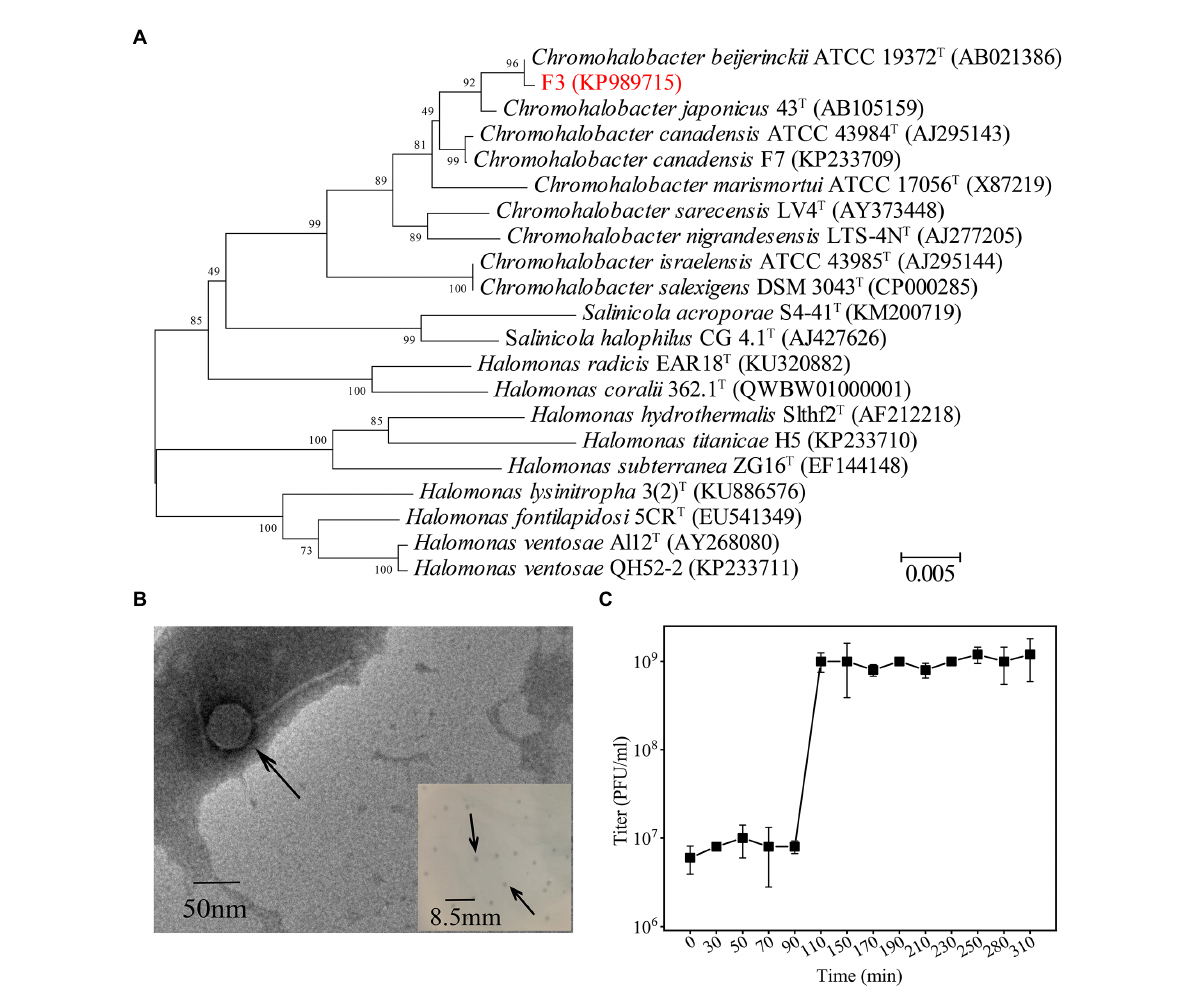
FIGURE 1 (A) Phylogenetic analysis of F3 based on the 16S rRNA gene sequence. Phylogenetic trees were constructed using the neighbor-joining method by Mega 7.0. All parameters are default except the Bootstrap value is 1,000, the p-distance model is used to calculate the distance, and the